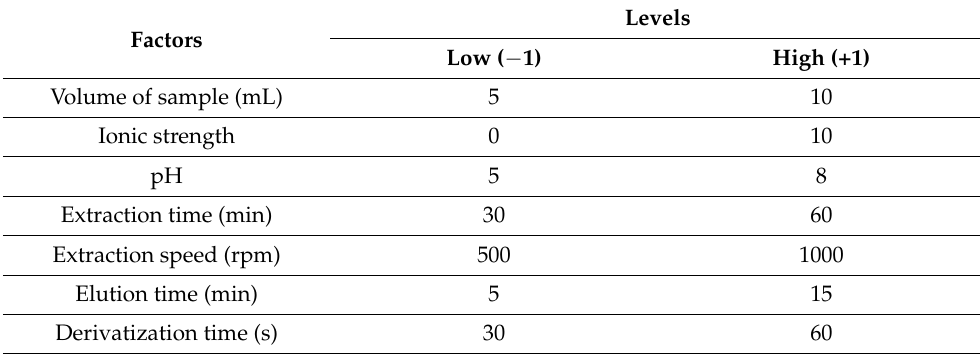
Table 1. Levels of independent variables for PBD